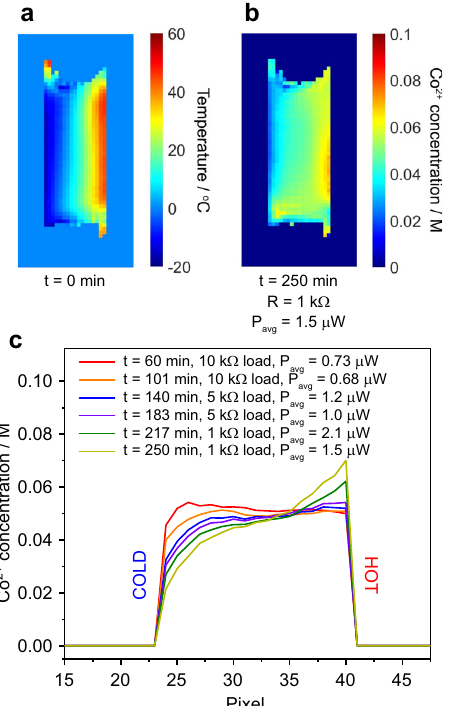
Fig. 5 Build-up of concentration gradients in the vertical electrode cell. a Temperature map and b Co 2 + concentration map obtained from the vertical electrode cell with the gel electrolyte. c One-dimensional Co 2 + concentration pro fi les across the centre of the cell, extracted from images obtained at the times t and under the load resistances R indicated (the yellow plot in ( c ) was taken from the image in ( b )). Average powers P avg drawn from the cells during the acquisition of each image are also quoted. The full series of images are provided in Supplementary Fig. 16, along with plots of cell current and voltage versus time for these experiments (Supplementary Fig. 12). gradient across the centre of the cell as a function of time and thermophoresis are minimal in this case, these Co 2 + concentra- tion data are quantitative, and can be correlated with the variations in measured cell potential and current (Supplementary Figs. 12 and 16). The Co 2 + concentration gradient evolves from